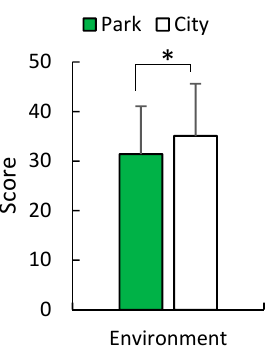
Figure 8. STAI score after seated-viewing in an urban park and the city in early summer. N = 12, mean ± standard deviation. * p < 0.05, determined by the Wilcoxon signed-rank test (one-sided).